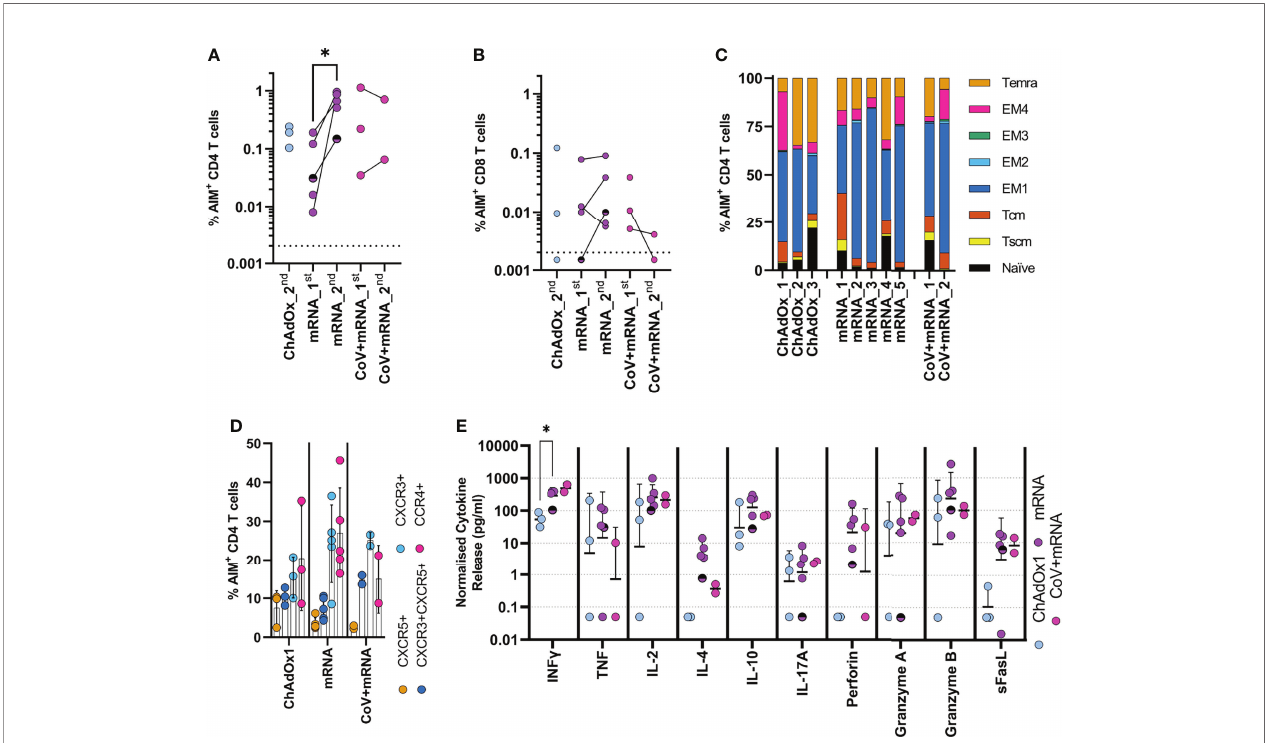
FIGURE 3 | Initial cellular responses in adolescents following COVID-19 vaccination. Analysis of the T-cell response following the second dose of vaccine. A fl ow cytometry-based AIM assay was used to identify responding (A) CD4 (CD69+CD40L+) and (B) CD8 (CD69+CD137+) T-cell frequency following overnight stimulation with an overlapping spike peptide pool. Where possible frequency was assessed 6 weeks after fi rst dose _1 st or 3 weeks after second dose _2 nd . Dots indicate individual donors. n = 3 ChAdOx1 (ChAdOx), n = 5 mRNA and n = 2 CoV+mRNA, half shaded mRNA symbol indicates the individual who received BNT192b2 vaccine. (C) Responding AIM+ CD4 T-cells from donors after second dose, were phenotyped, to assess memory state. Bars represent individual donors receiving the indicated vaccine type, numbers indicate individual donors and show the proportion of the AIM+ CD4 T-cell population with each memory phenotype in each donor. T effector memory (CD45RA-CCR7-, EM) are subdivided as EM1 – CD27+CD28+, EM2 – CD27+CD28-, EM3 – CD27-CD28-, EM4 - CD27-CD28+). (D) the expression of homing and polarisation markers CXCR5, CXCR3, and CCR4 by AIM+ CD4 T-cell population was also assessed and expressed as a proportion of the